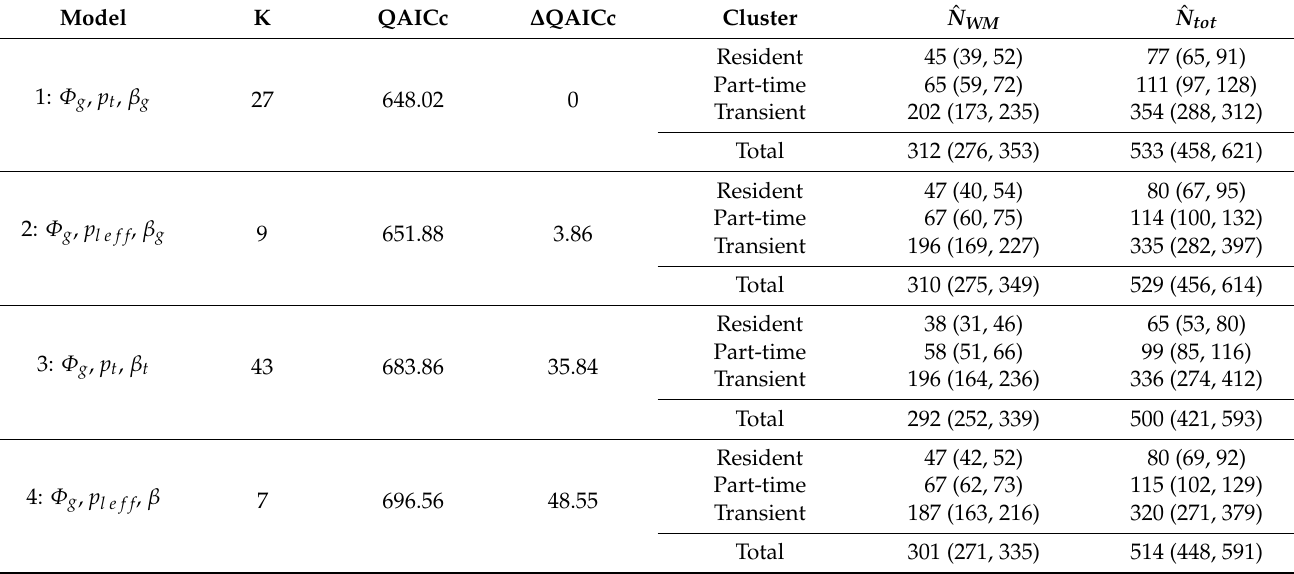
Table 2. Best models in terms of quasi-likelihood Akaike’s information criterion (QAICc) with the corresponding number of parameters k . Point estimates (and 95% confidence interval) of the WM ( ˆ N WM ) and overall ( ˆ N tot ) population by group. Model